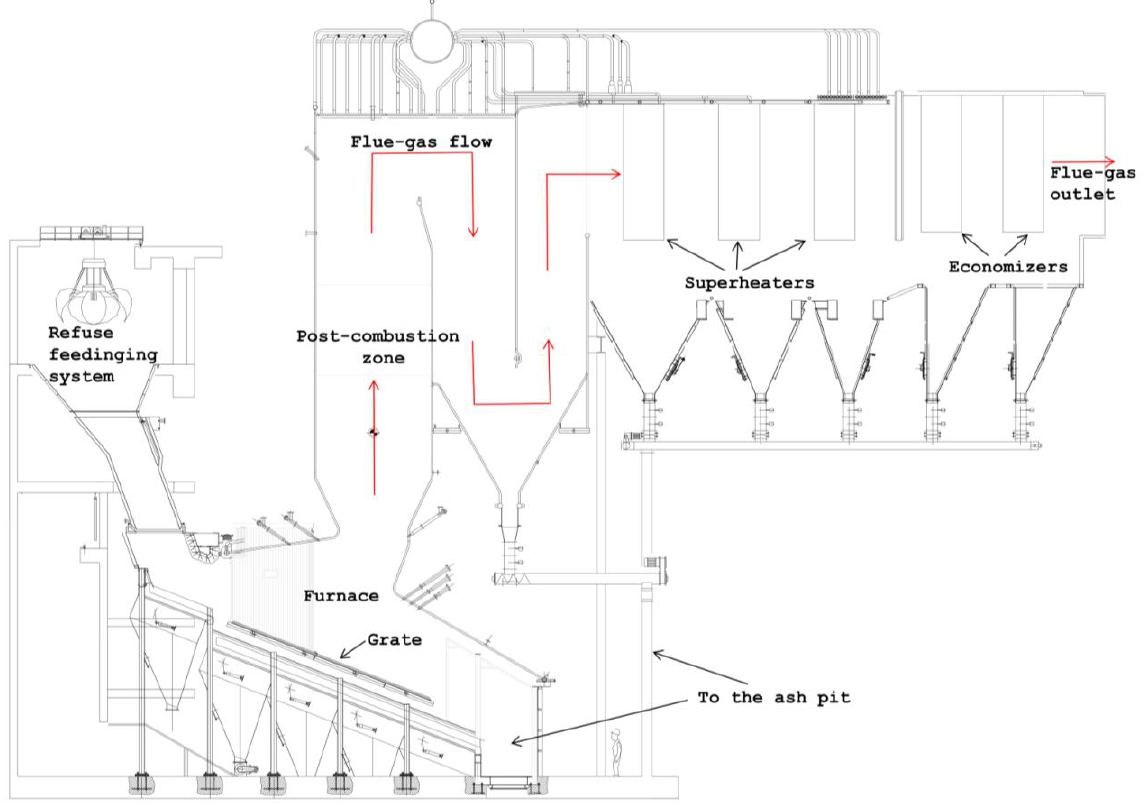
Figure 1. Typical waste to energy (WTE) boiler